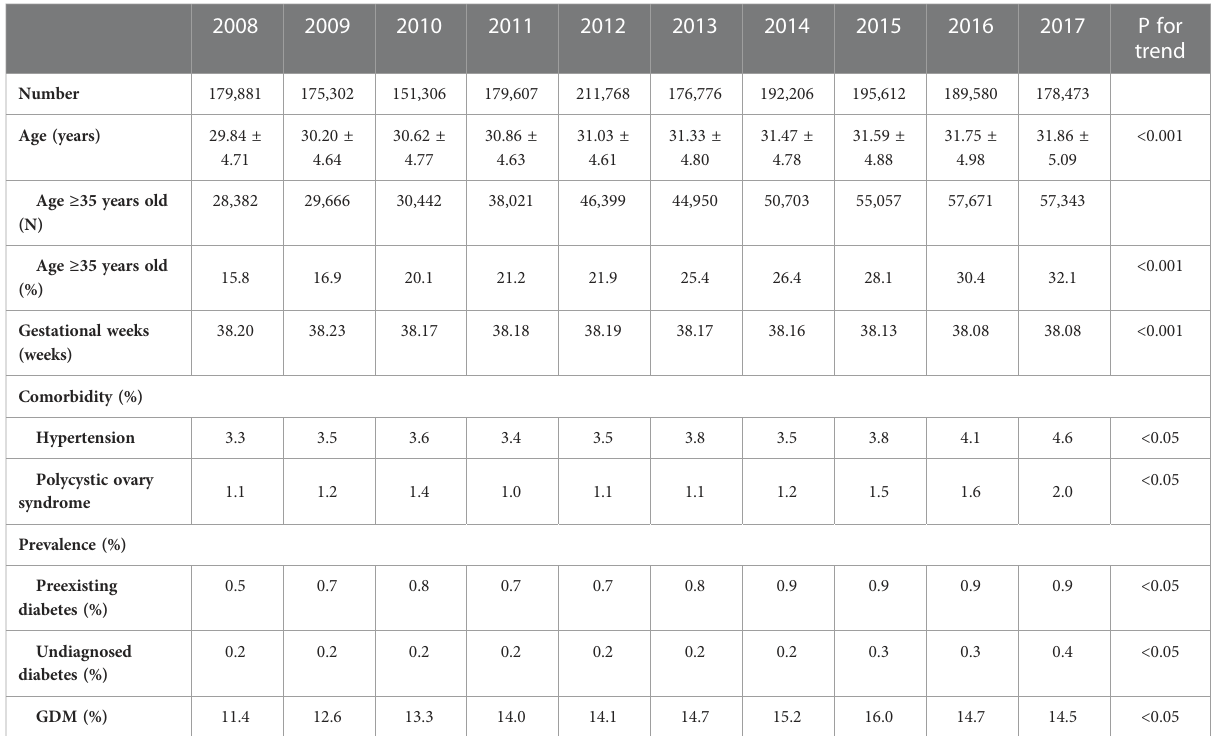
TABLE 1 Clinical characteristics and prevalence of hyperglycemia in pregnancy in pregnant women in Taiwan in